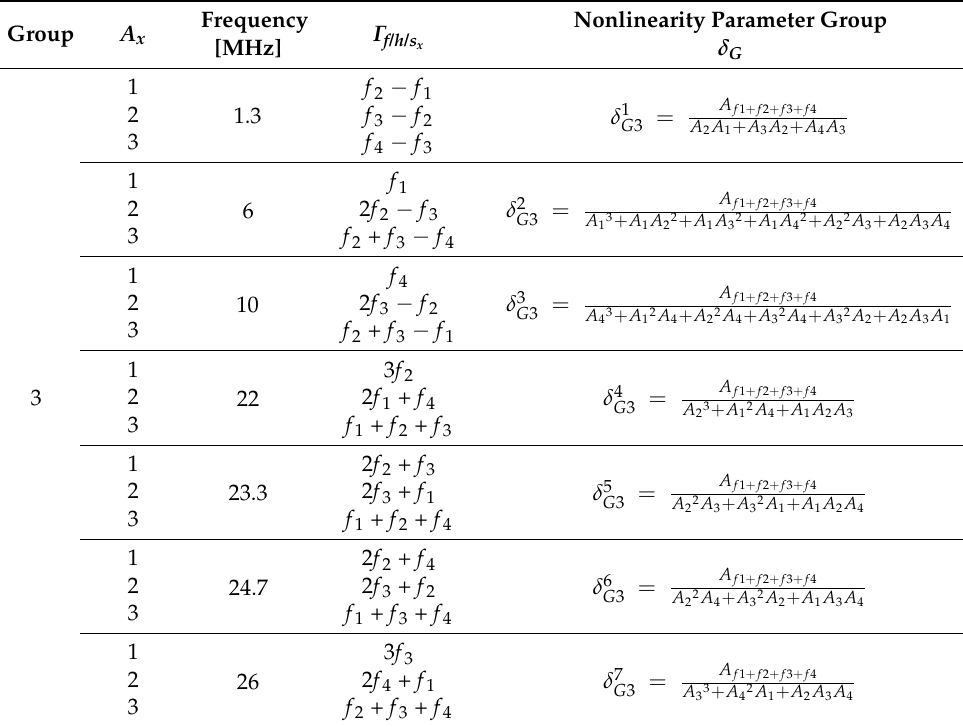
Table 4. Nonlinearity parameter group 3, δ G 3 .